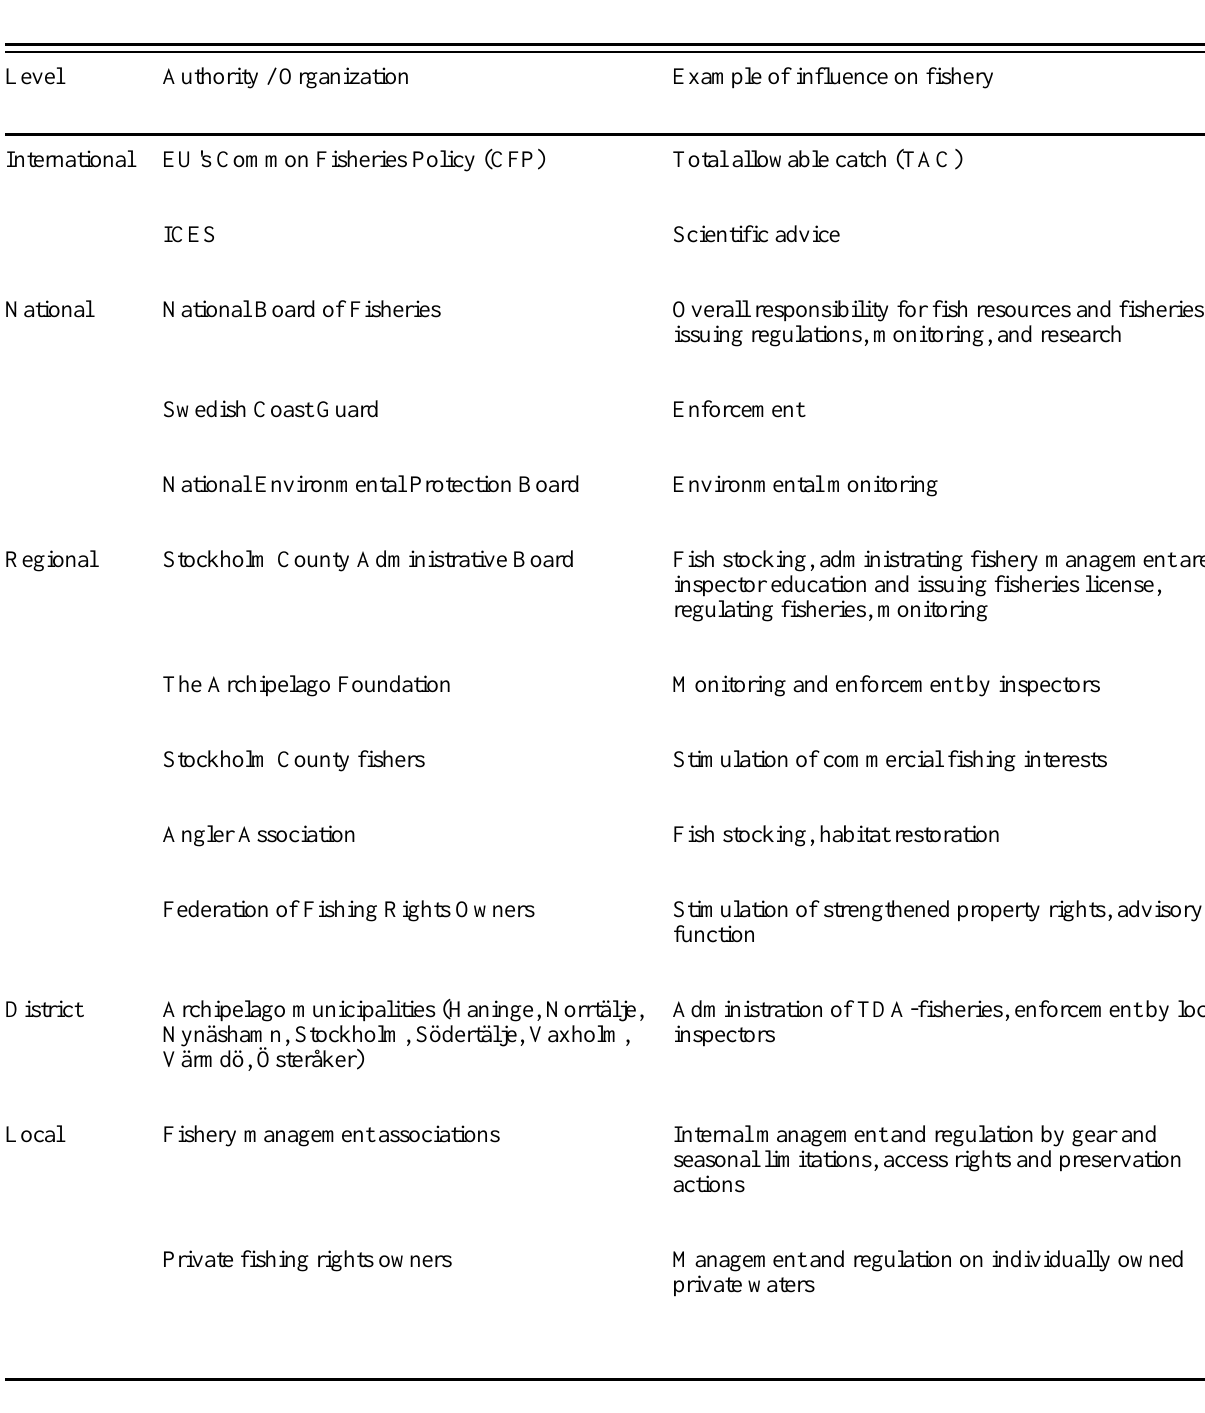
Table 1. Authorities and organizations involved in regulating and managing fishing waters in Stockholm Archipelago, divided into five organizational